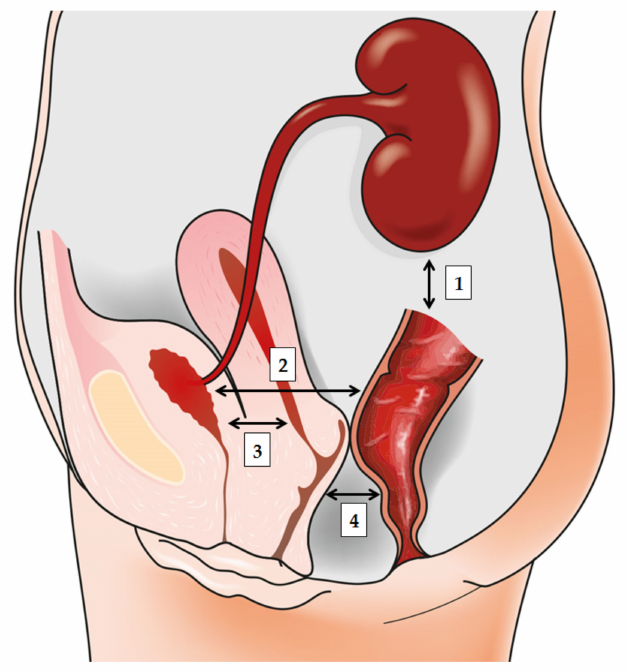
Figure 1. Bidirectionally informed communication between the gut, urinary tract, and genital tract: (1) gut–kidney axis that plays a role in various renal disorders; (2) gut–bladder axis and the link between the “intestinal bloom of uropathogens” and UTI development; (3) vagina–bladder axis where vaginal dysbiosis may prompt UTI development acting as a reservoir for Escherichia coli or prompting “covert pathogenesis”; (4) gut–vagina axis where intestinal dysbiosis may influence the local vaginal